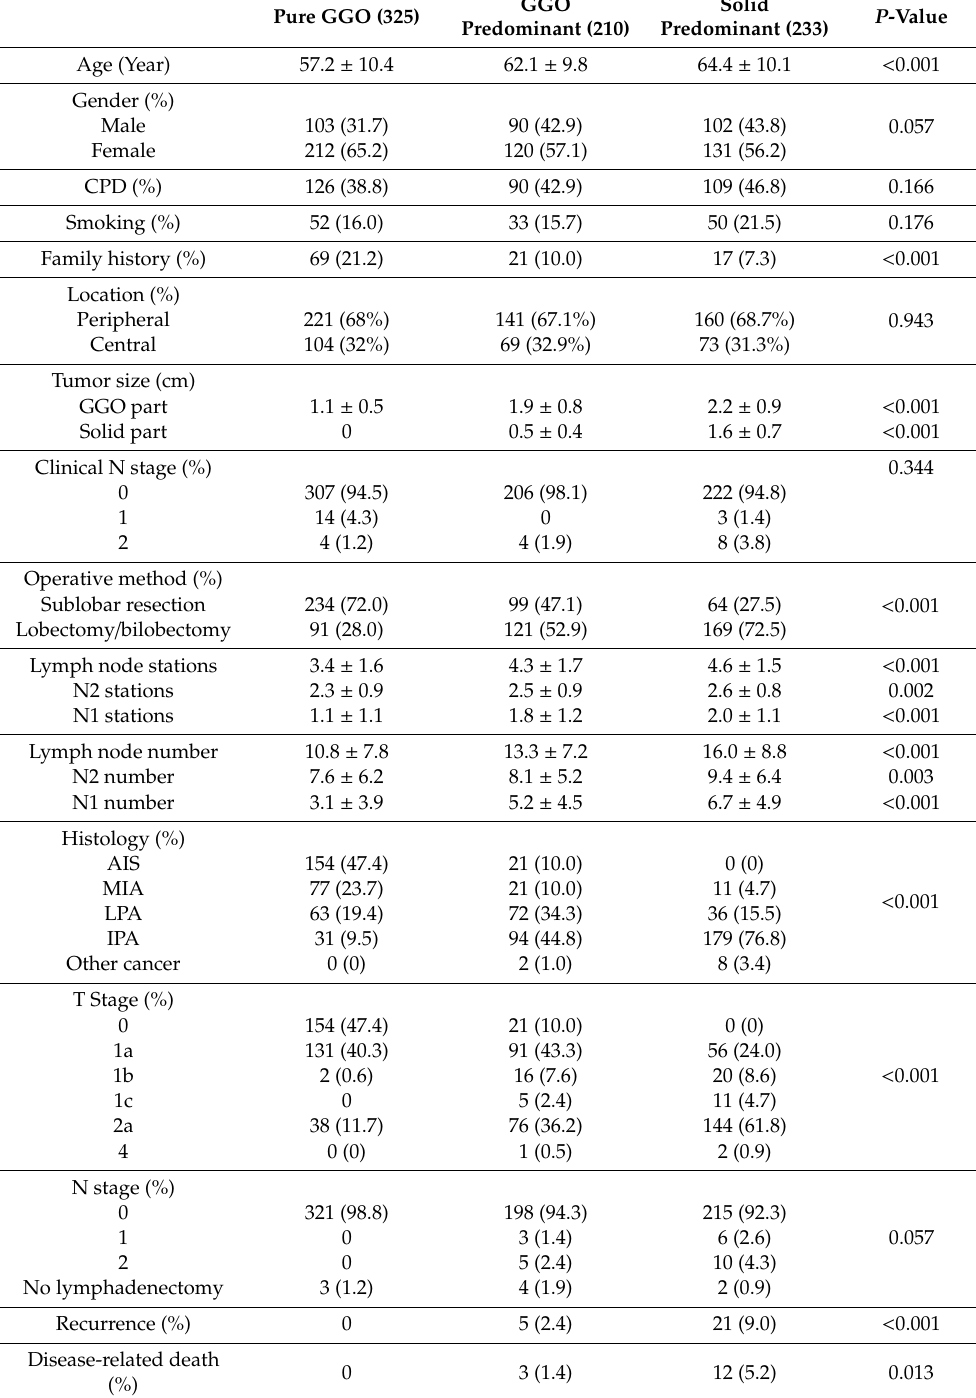
Table 1. Demographics for patients with pure GGO or part solid